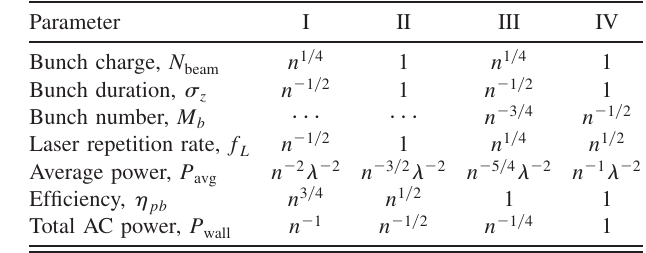
TABLE III. Plasma density and laser wavelength scalings in the